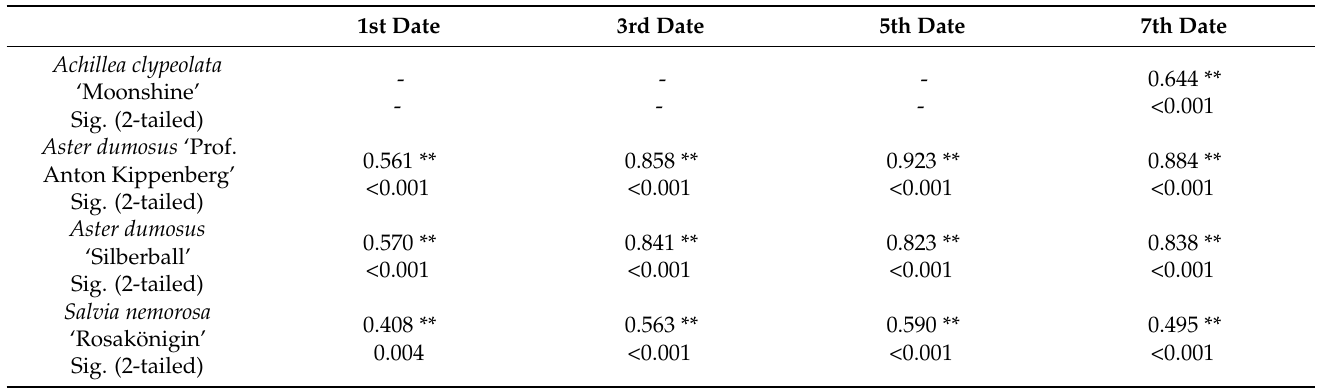
Table 7. Pearson correlation between nitrogen content and plant height.